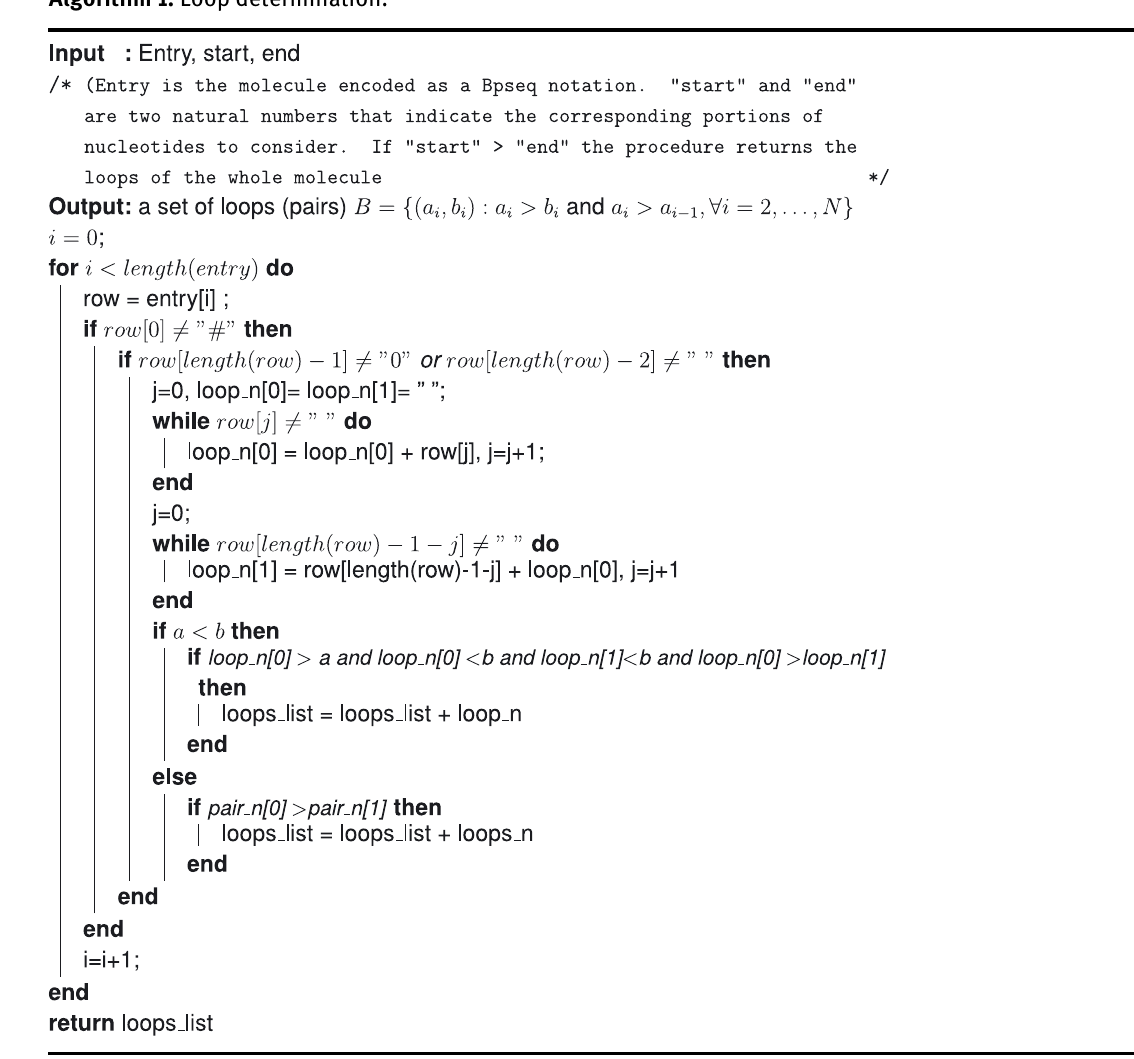
Algorithm 1: Loop